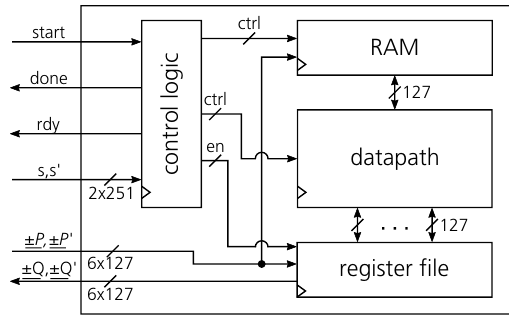
Figure 1: Single-core architecture, which contains all control and datapath logic for computing Algorithm 1 ( scalar _ mult